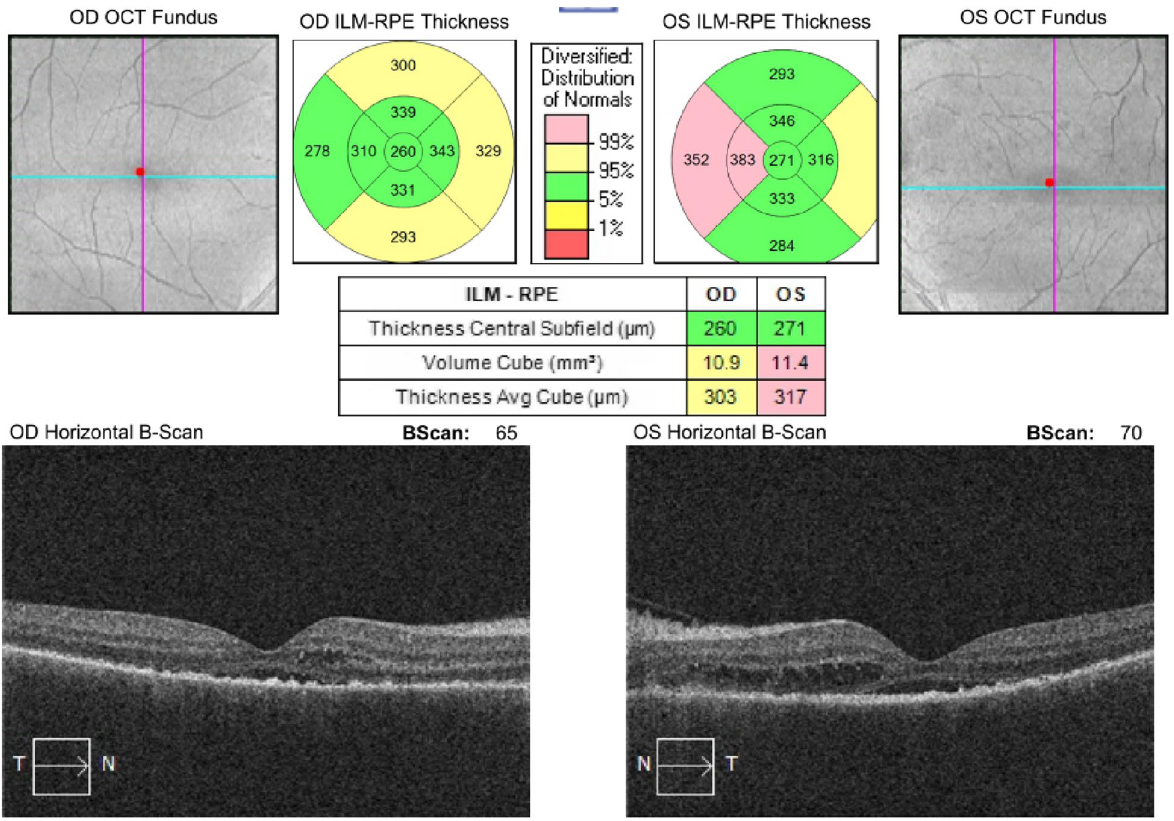
Fig. 4 06.09.2021: BCVA